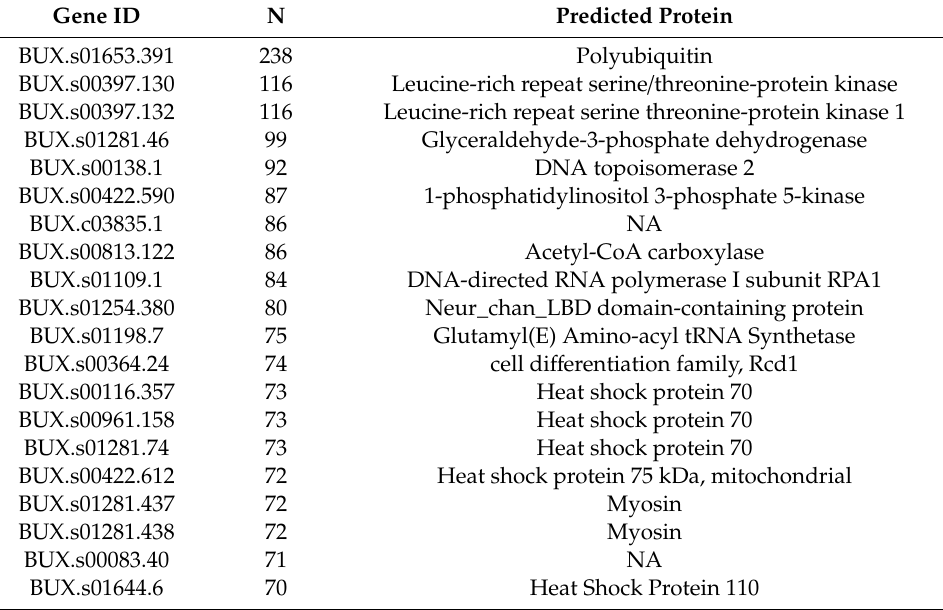
Table 4. Genes that interacted with many di ff erentially expressed genes of B. xylophilus between aseptic condition and with S. maltophilia .